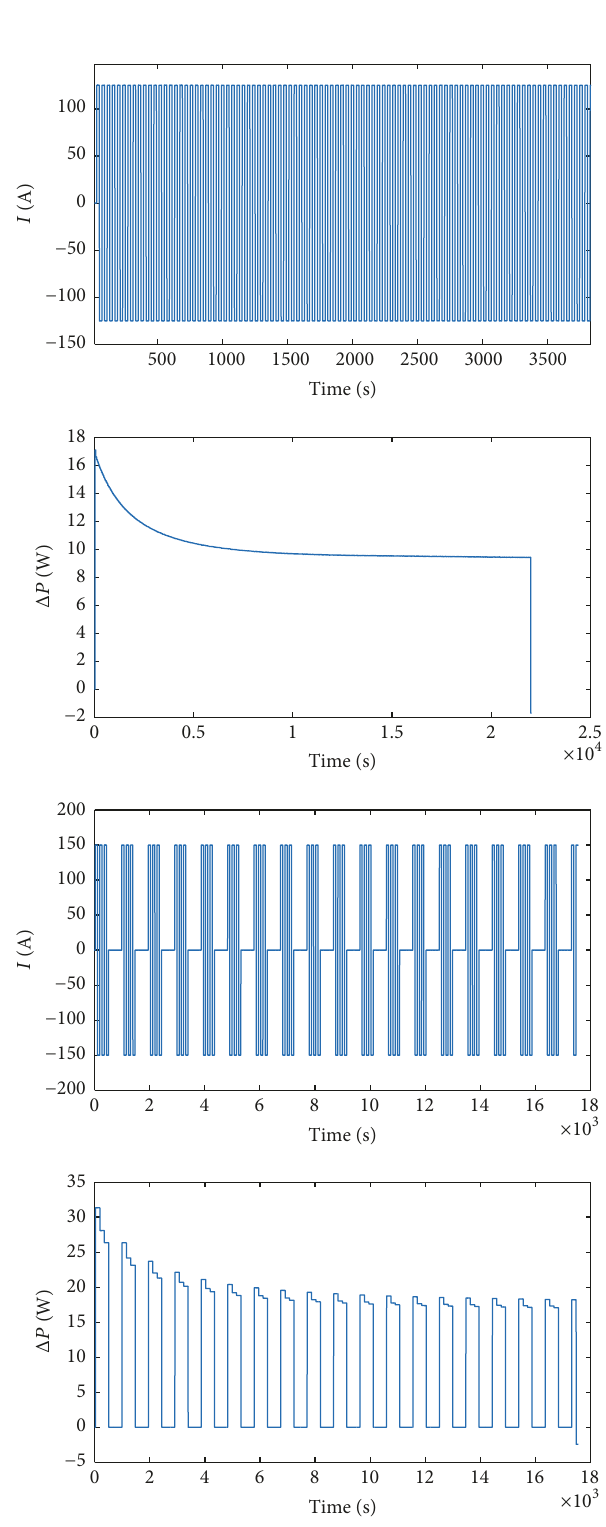
Figure 5: Load current and average power dissipation for the two measurement sets (1,